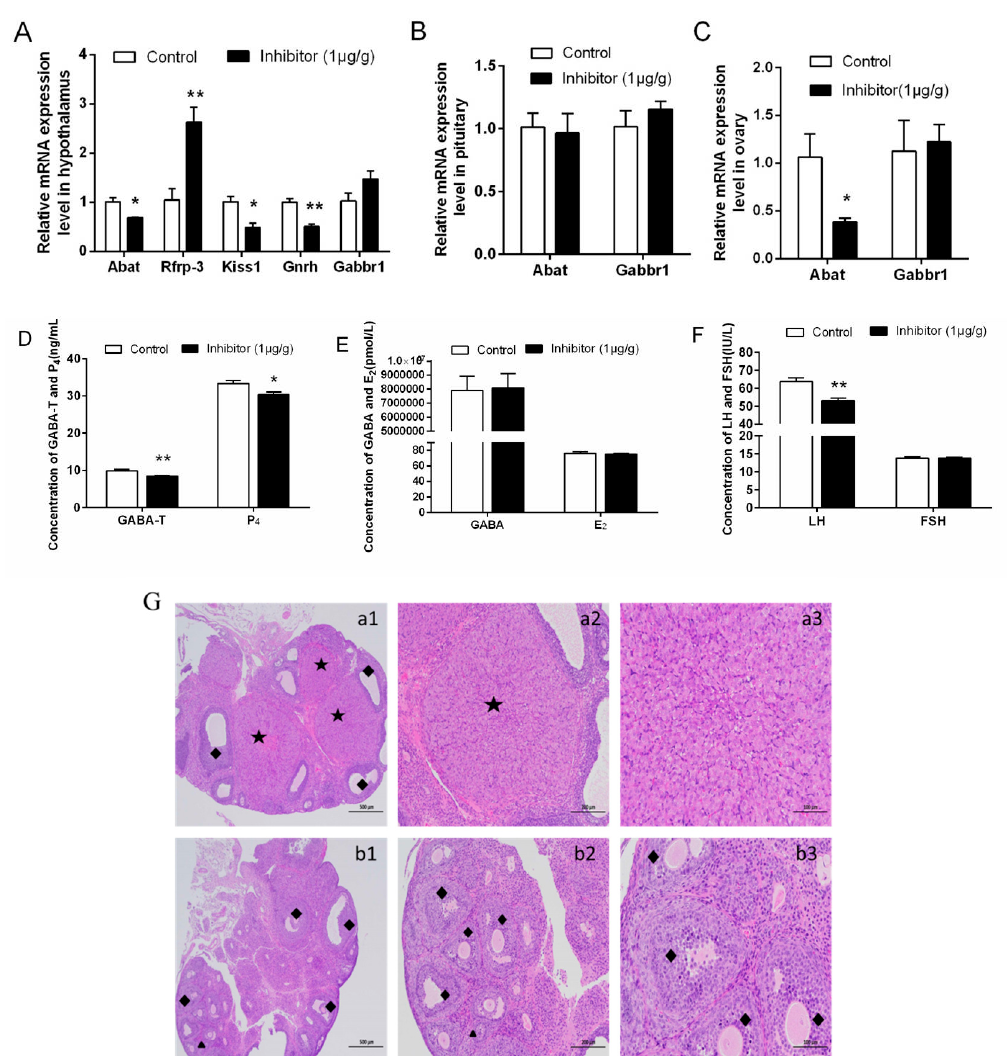
Figure 3. The reproduction-related genes expression, serum hormone content and ovarian morphology in 25d rats injected with GABA-T inhibitors until VO. ( A ) Expression of Abat mRNA and reproduction-related genes in hypothalamus at VO. ( B ) Expression of Abat and Gabbr1 mRNA in pituitary at VO. ( C ) Expression of Abat and Gabbr1 mRNA in ovary at VO. ( D ) The content of GABA-T and P 4 in rat serum at VO. ( E ) The content of GABA and E 2 in rat serum at VO. ( F ) The content of LH and FSH in rat serum at VO. ( G ) Histological assessment of follicles using H&E staining (a: Control group; b:GABA-T inhibitor group; the scale bar: of 1, 2, 3 are 500 μ m, 200 μ m, 100 μ m). ** indicates a very significant difference ( p < 0.01); * indicates a significant difference ( p < 0.05). Vigabatrin was used as a GABA-T inhibitor.